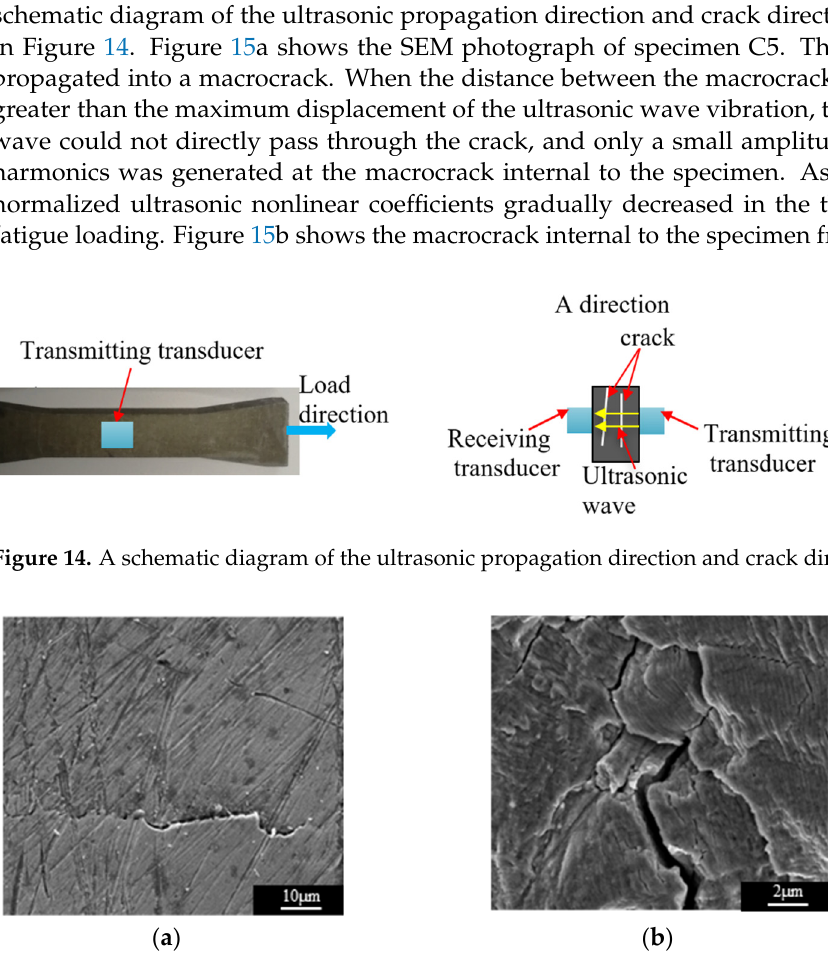
Figure 13. The breathing effect of the crack under a tensile and compressive load of the ultrasonic. ( a ) The crack is compressed and closed. ( b ) The crack is stretched and opened.